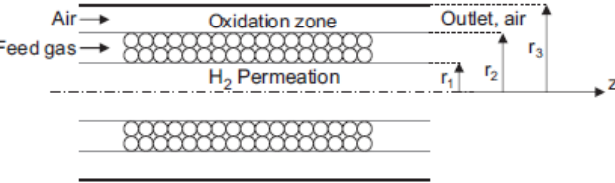
Figure 7. Conceptual scheme of a double-jacketed MR. With permission of reprint of Elsevier from Wu and Fu [54].